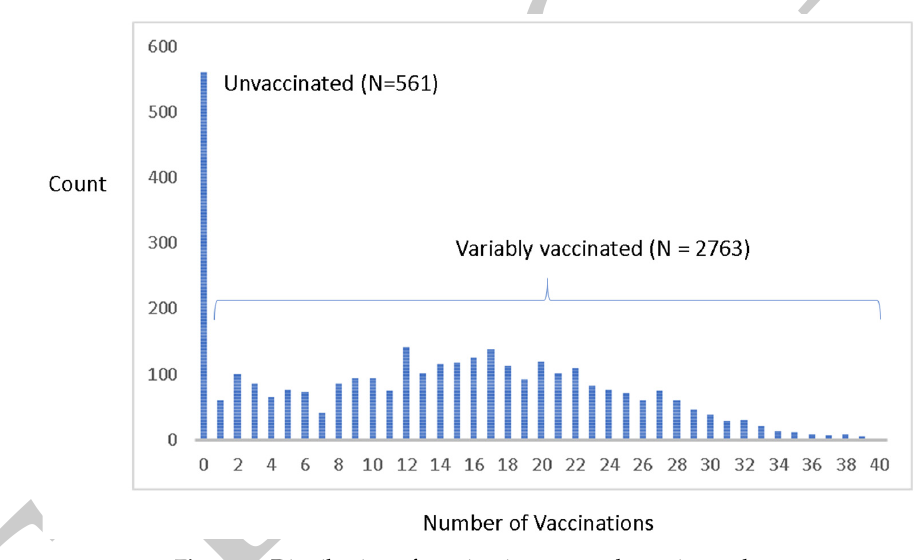
Figure 2. Distribution of vaccination across the patient